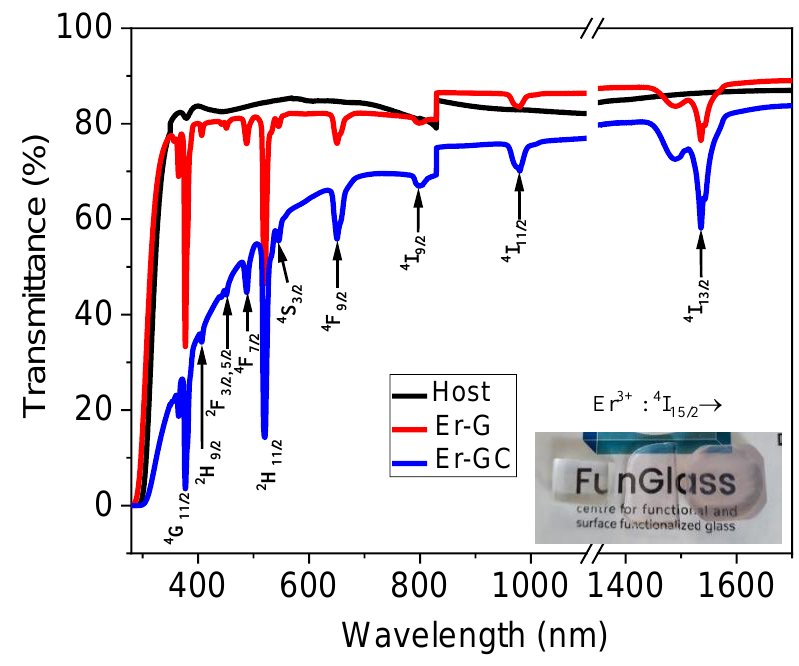
Figure 5. UV–vis–NIR transmittance spectra of the host, Er-G and Er-GC.